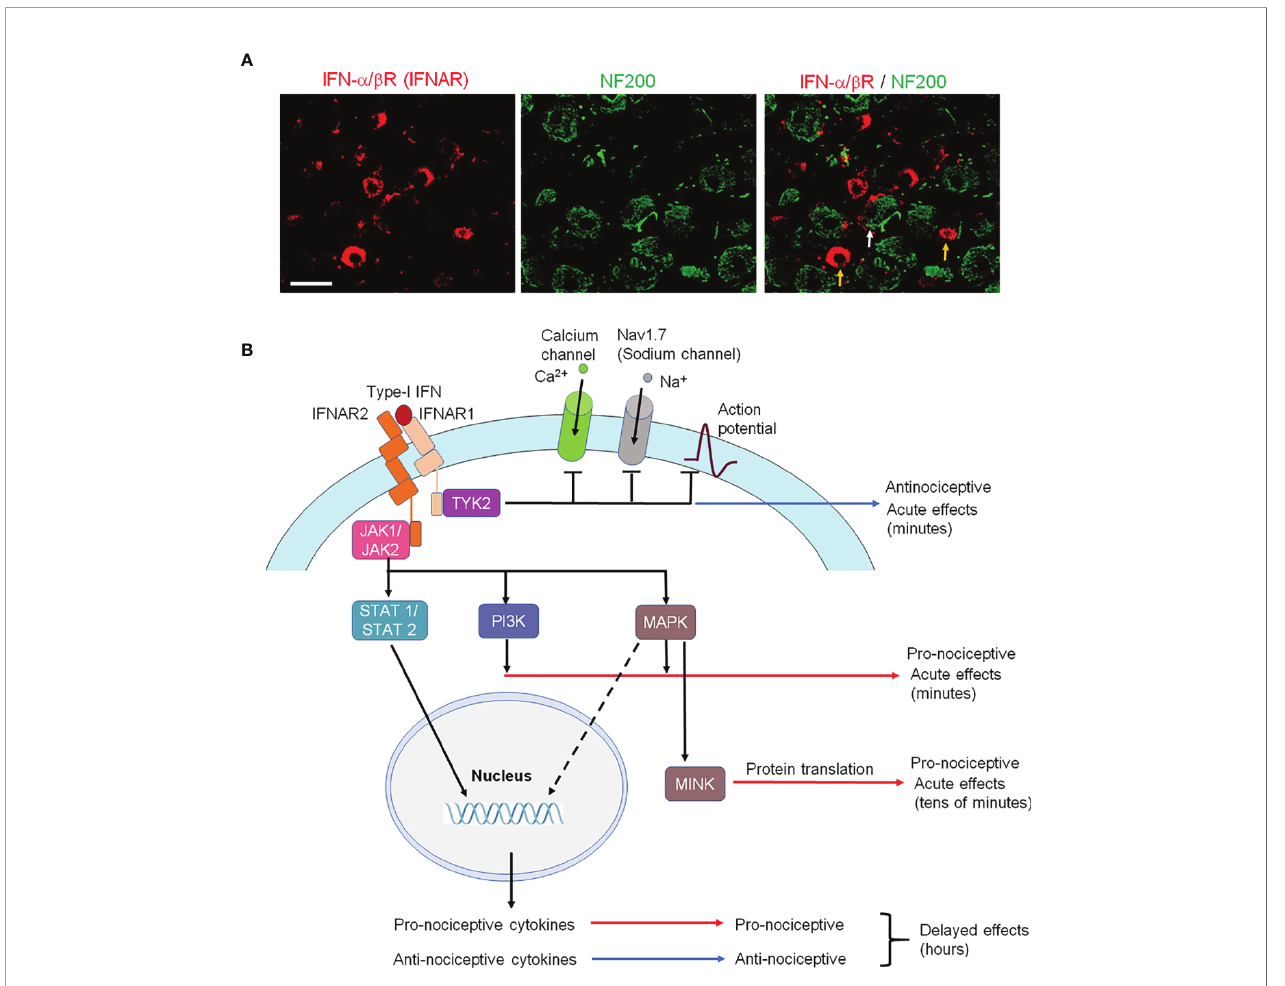
FIGURE 3 | IFNAR signaling in nociceptive sensory neurons and its involvement in pronociceptive and antinociceptive effects. (A) Double staining of IFN a / b R (IFNAR) and NF200 in L3-L5 DRG neurons of naïve rats. Note that IFNAR is mainly expressed in NF200-negative nociceptive neurons (orange arrows) and some NF200-postive neurons (white arrow). Scale, 50 m m. Reproduced from Ref 95 (50) with permission. (B) Type-I IFN activates IFNAR1, resulting in subsequent TYK2 activation and rapid antinociception via inhibition of Na + and Ca 2+ channels and suppressing of action potential fi ring in nociceptors at central nervous system. IFNAR-mediated activation of JAK also results in activation of PI3K and MAPK pathways, as well as MINK/eIF4E-mediated translational pathway, leading to nociceptor sensitization at peripheral nervous system. Furthermore, IFNAR-mediated STAT activation causes delayed effects via induction of pro-in fl ammatory and anti-in fl ammatory cytokines, leading to pro-nociceptive and anti-nociceptive actions in the late-phase at central nervous